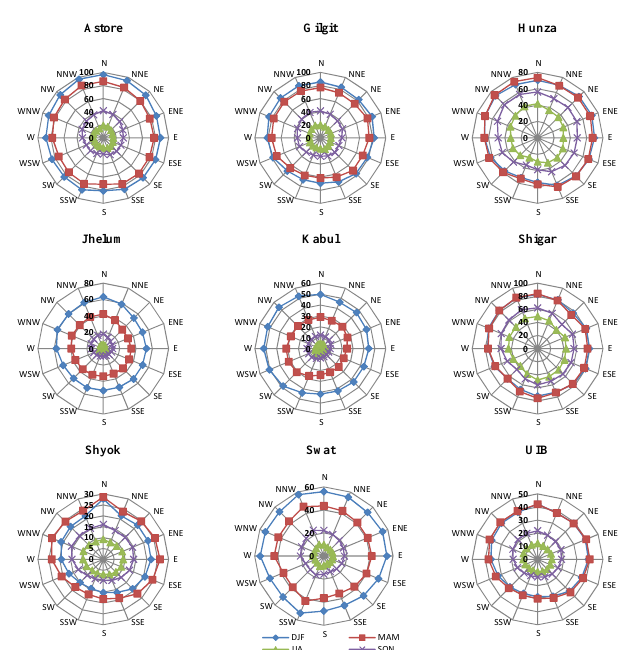
Figure 13. Aspect-wise distribution of snow cover (in percentage) during the winter (DJF), spring (MAM), summer (JJA) and autumn (SON) seasons for the nine study